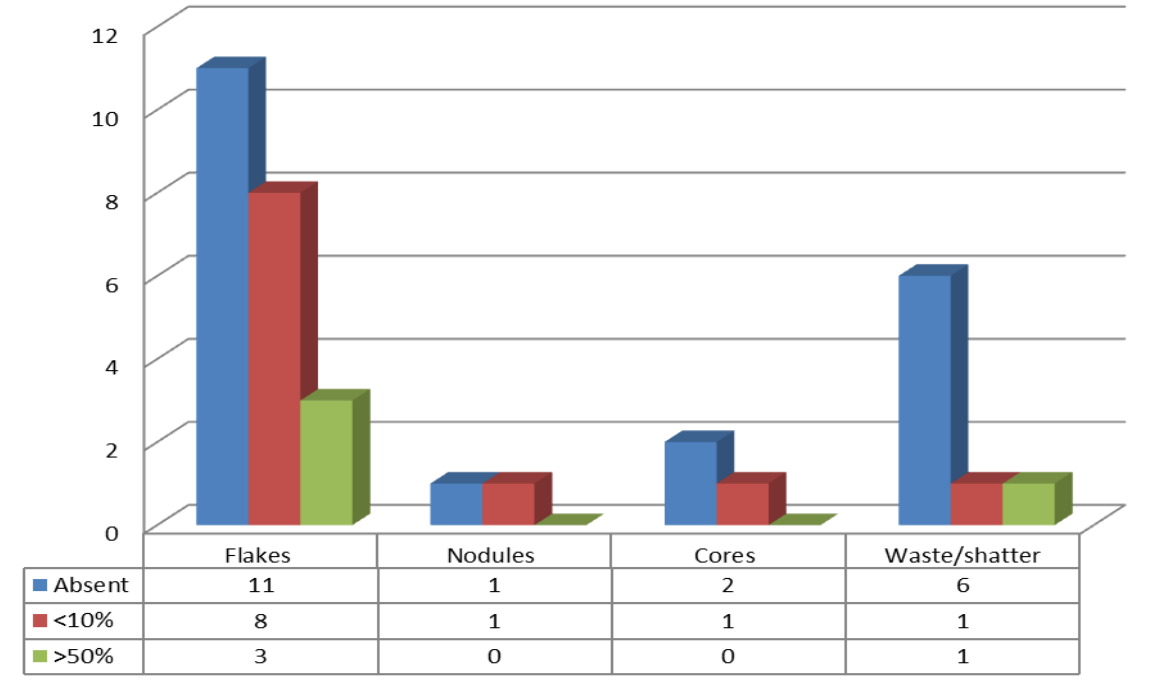
Figure 6. Distribution of lithic